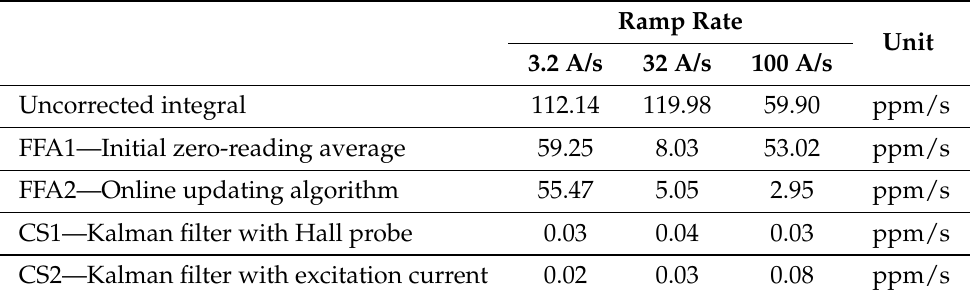
Figure 8. Comparison of case study 1 and 2 algorithms (black and green, respectively) with the algorithm FFA2 on the last flat-top, when a ramp rate of 100 A/s is applied. Table 2. Global relative drift values expressed by means of the parameter δ G